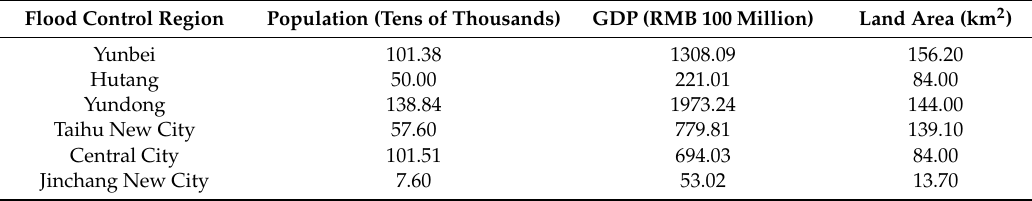
Table 2. Socio-economic development indicators of flood control regions.